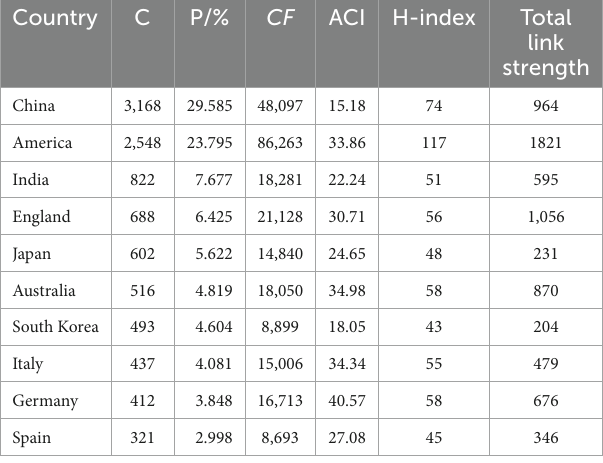
TABLE 1 Top 10 countries by the volume of publication.